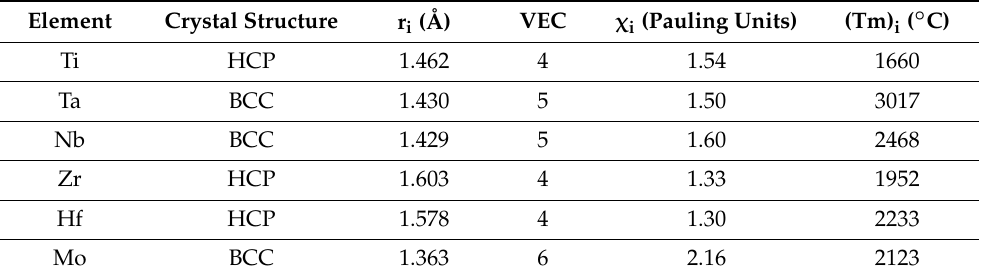
Table 1. Physical properties of pure alloying elements: Crystal structure, atomic radius—r i , valence electron concentration—(VEC) i , Pauling’s electronegativity— χ i , and melting point—T(m) i . BCC: Body-centered cubic: HCP: hexagonal closest packed